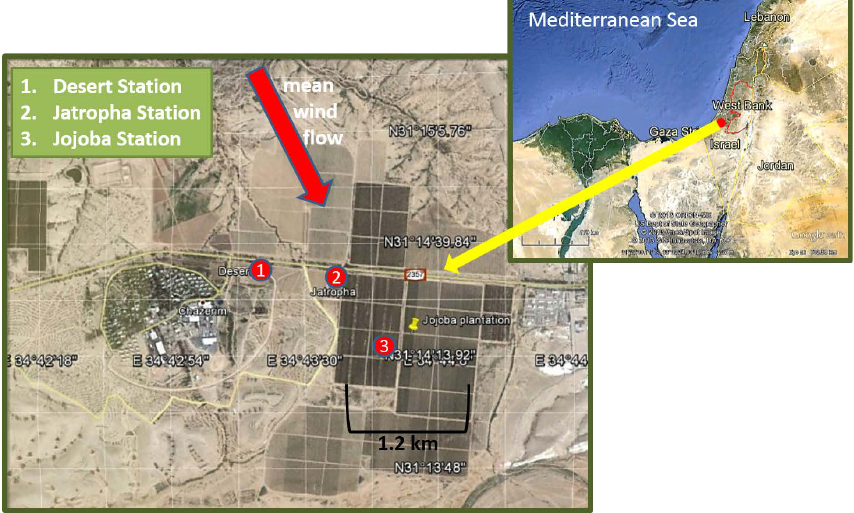
Fig. 1. The region of interest over Israel at the eastern edge of the Mediterranean Sea (inset) and the location of the three meteorological stations at Kibbutz Hatzerim in the centre of Israel, 40km from the coast (the regional location is indicated by in the inset box). The location of the stations Desert (1), Jatropha (2) and Jojoba (3) are marked on the left-hand image. Mean wind flow is marked with an arrow. Table 1. Measured quantities from Desert, Jatropha and Jojoba cases, sensor type and estimated measurement errors. Measurement errors are rated usually within a range of, or at a given temperature. Where this is applicable, the temperature range is indicated by and at sign. Quantity Sensor Estimated